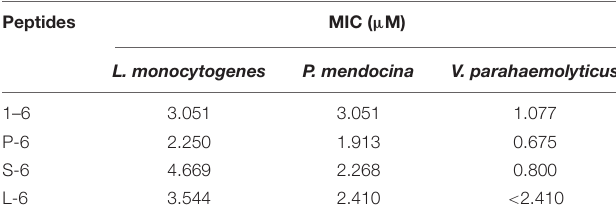
TABLE 3 | Minimum inhibitory concentrations (MICs) of four antimicrobial peptides against bacteria. Peptides MIC ( µ M)